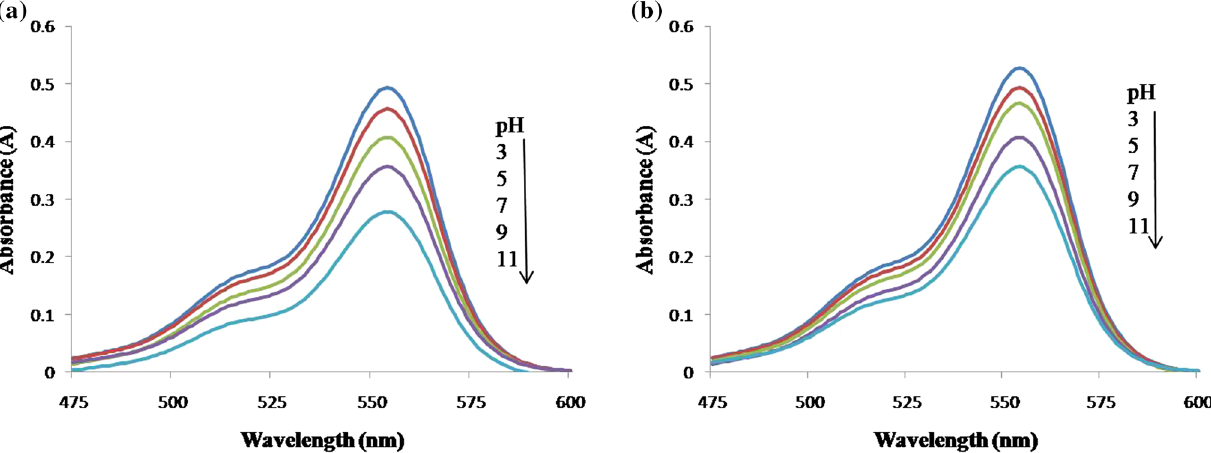
Fig. 12 UV–Vis spectra of RB dye under UV light irradiation in the presence of A-MWCNTs/Co–Ti oxides and Co–Ti oxide NPs in different pH